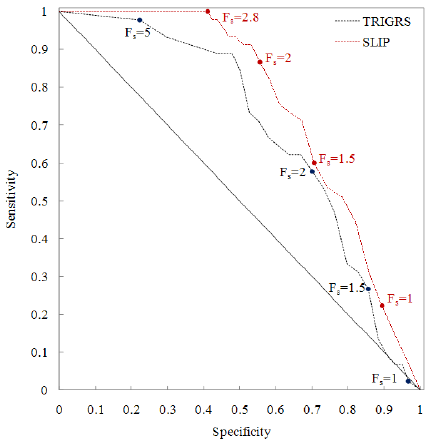
Figure 11 Fig. 11. ROC curves corresponding to SLIP and TRIGRS analyses on the test-area for soil slips occurred on the 11 April